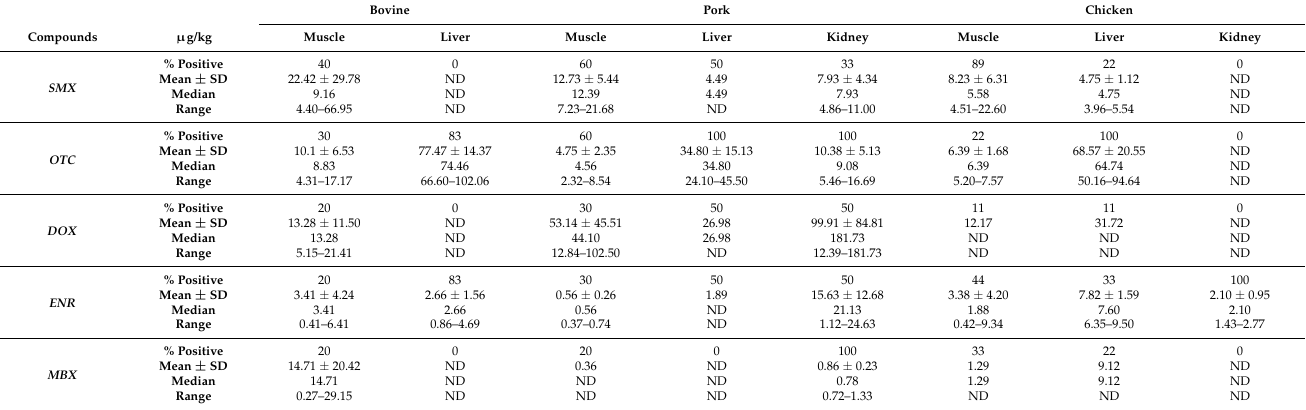
Table 3. Monitoring results ( µ g/kg) of antibiotics in all meat samples by LC–MS analysis.